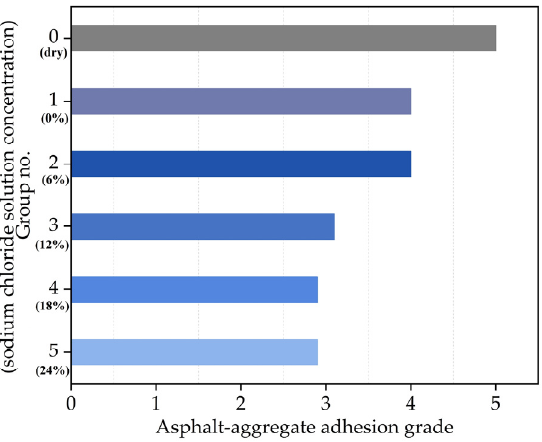
Figure 8. The asphalt–aggregate adhesion grade of asphalt with different chloride salt concentra- tions.